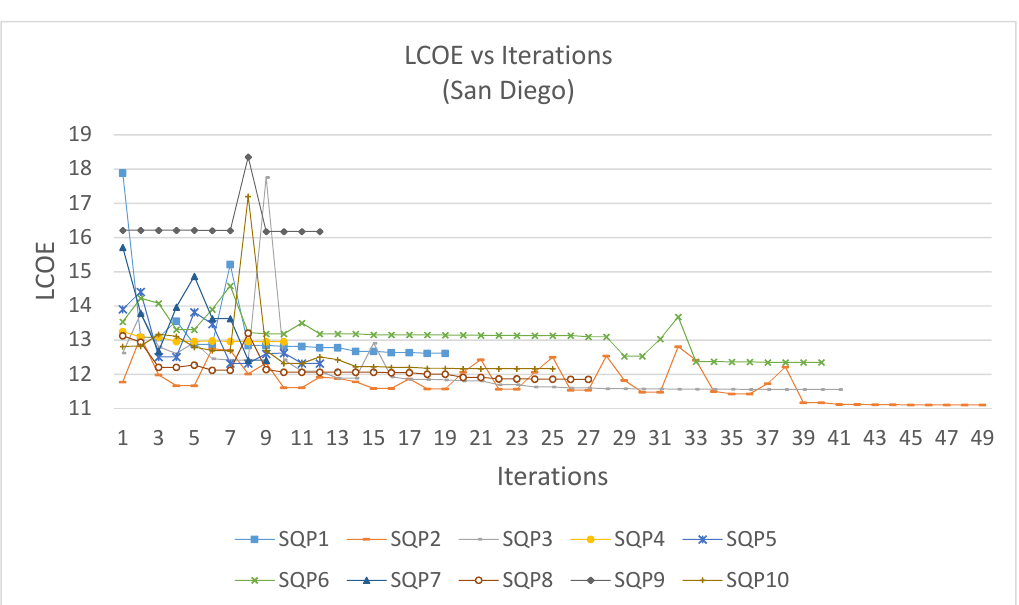
Figure 4. Optimization iteration summary for Jacksonville. 395